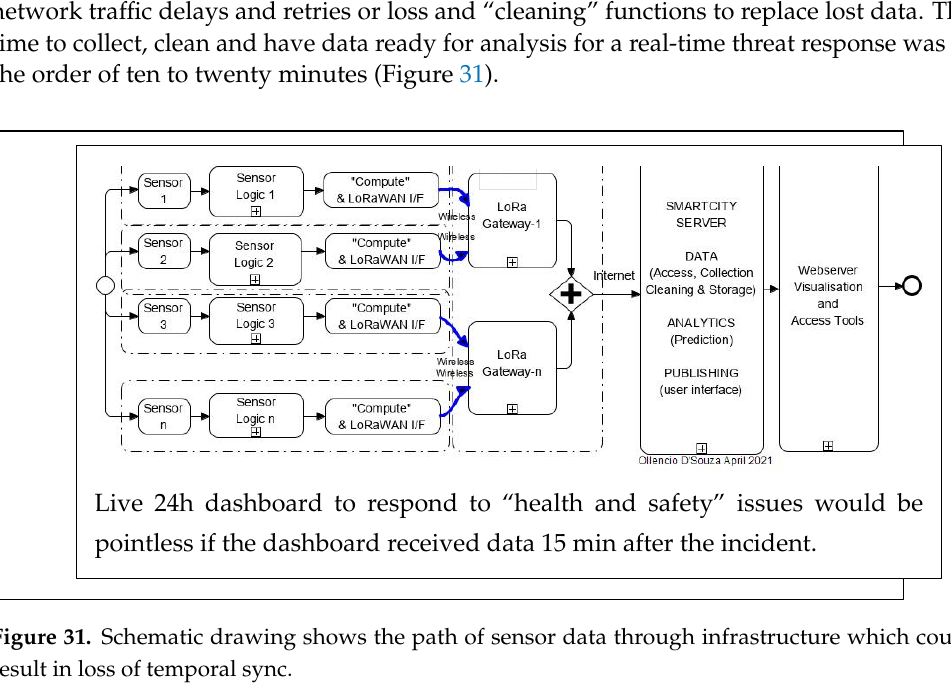
20 of 24 Figure 29. Test results—”event detection” trials.